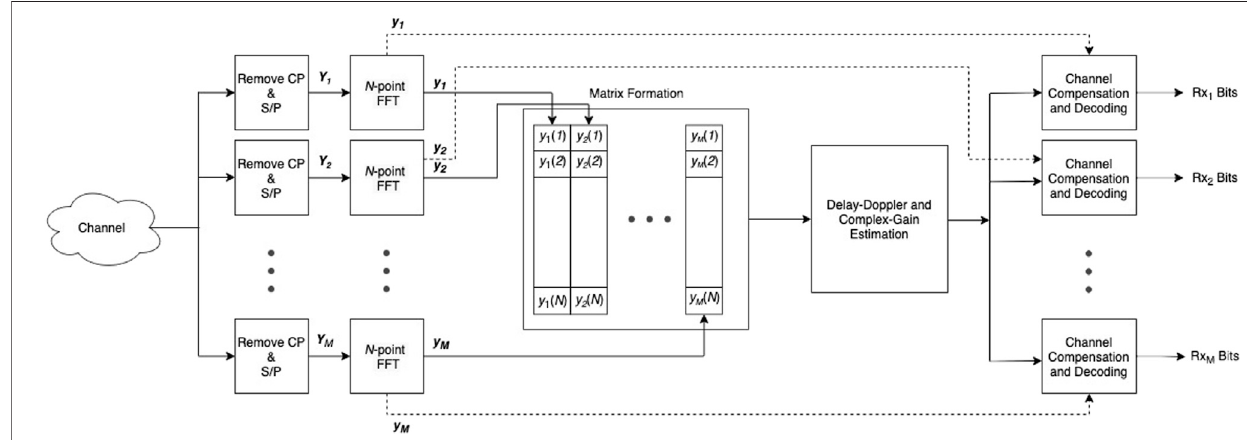
FIGURE 3 | Decoding process for an OFDM-IM frame of the proposed DFRC